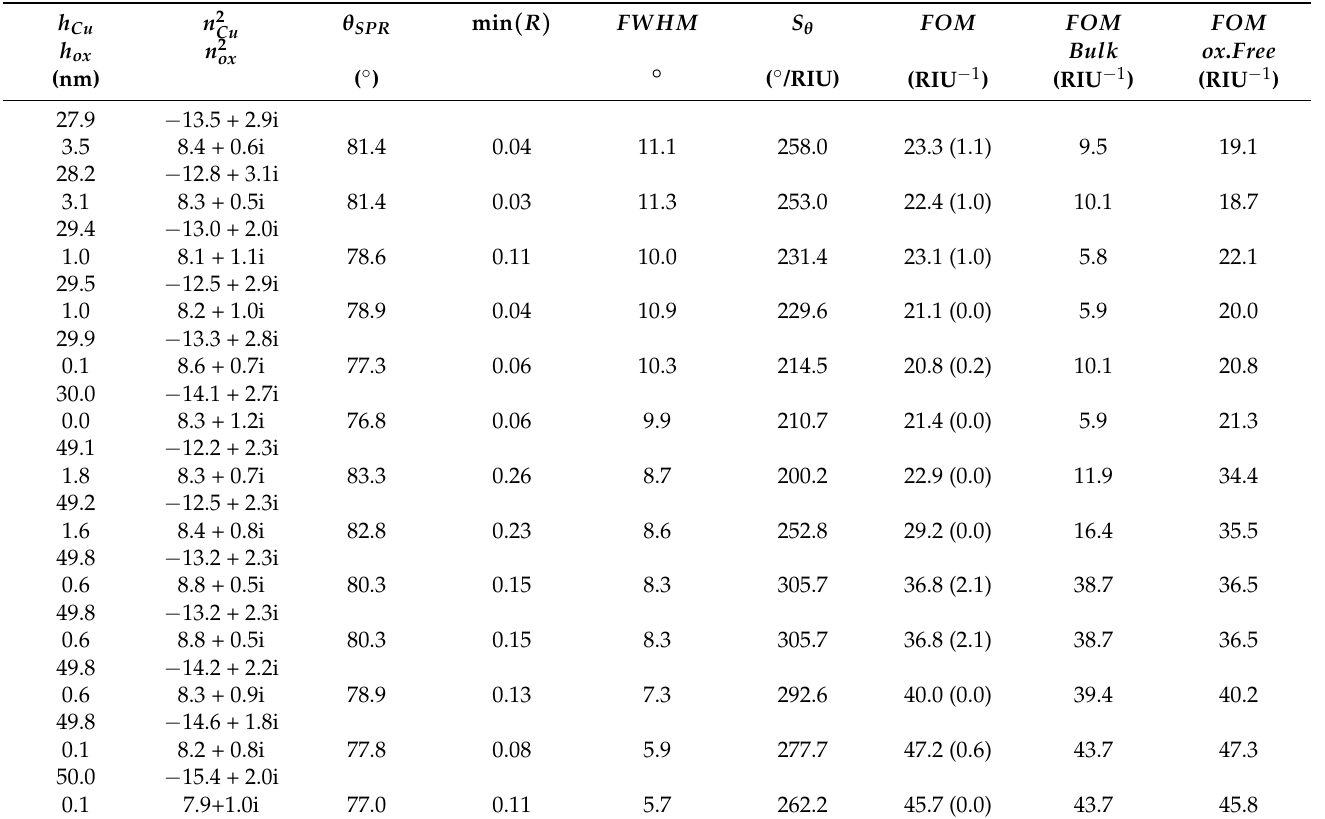
Table 2. Calculated performance of the SPR setup given the retrieved thicknesses and optical properties in the wet case: resonance angle, the depth of SPR dip, full width at half maximum, sensitivity and figure of merit (only FOM > 20 RIU − 1 are indicated) and its uncertainty, FOM for optical properties of bulk materials, and for bare copper (without